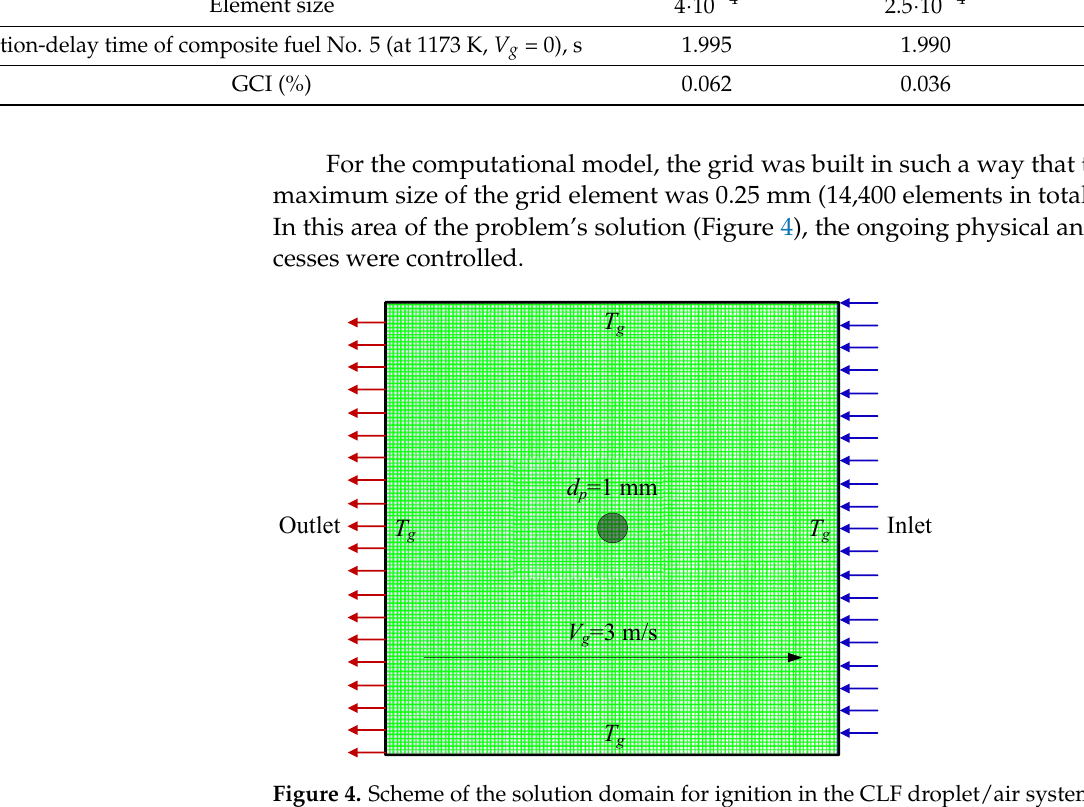
Figure 4. Scheme of the solution domain for ignition in the CLF droplet/air system. A single droplet injection system was used to generate a CLF droplet with the initial temperature T p ,0 = 300 K and size d p = 1 mm. It was placed in the geometric median of the solution domain in Figure 4 (X-position = 0.015 m; Y-position = 0.015 m). At the initial